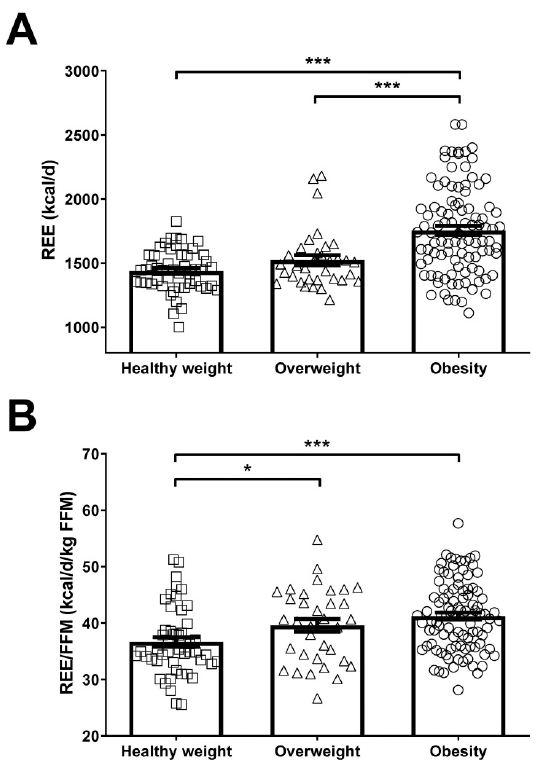
Figure 1. Comparison of absolute REE ( A ) and normalized by FFM ( B ) in children and adolescents with healthy weight, overweight or obesity. Values are means ± SEM. Statistical differences between groups were analyzed by ANOVA followed by LSD tests. * p < 0.05 and *** p < 0.001 between groups. REE, resting energy expenditure; FFM, fat-free mass.